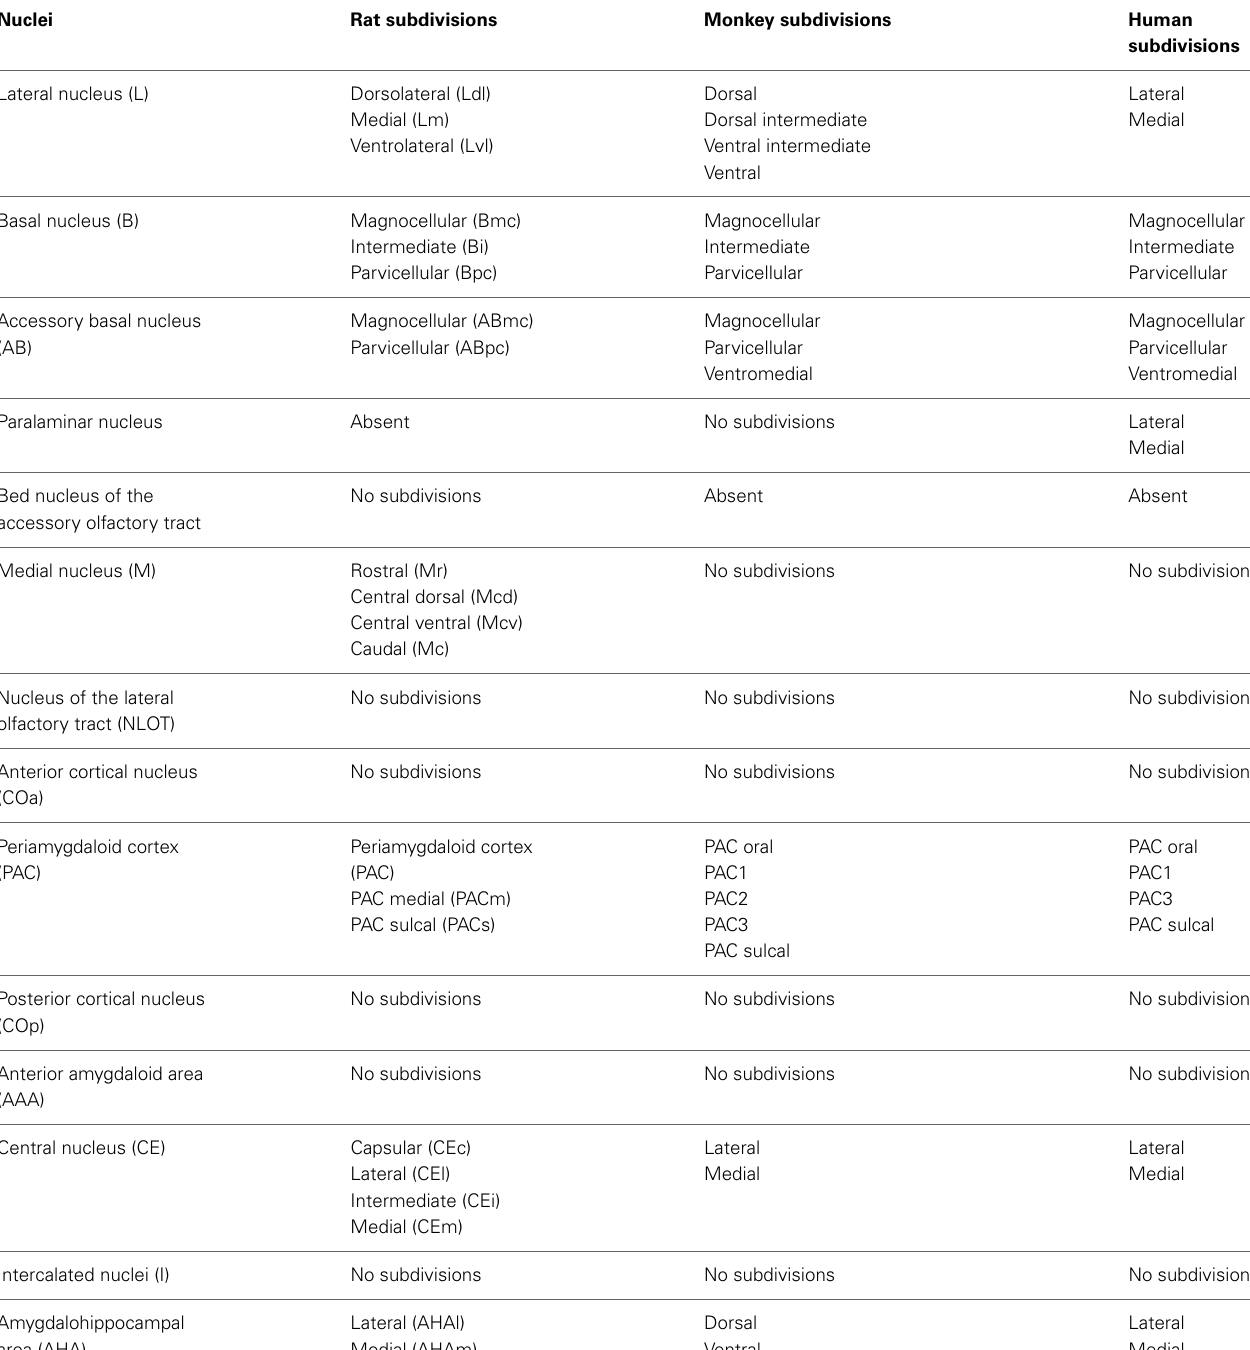
Table 1 | Nuclei and nuclear subdivisions of the rat, the monkey and the human amygdala (modified from Pitkänen and Kemppainen, 2002).